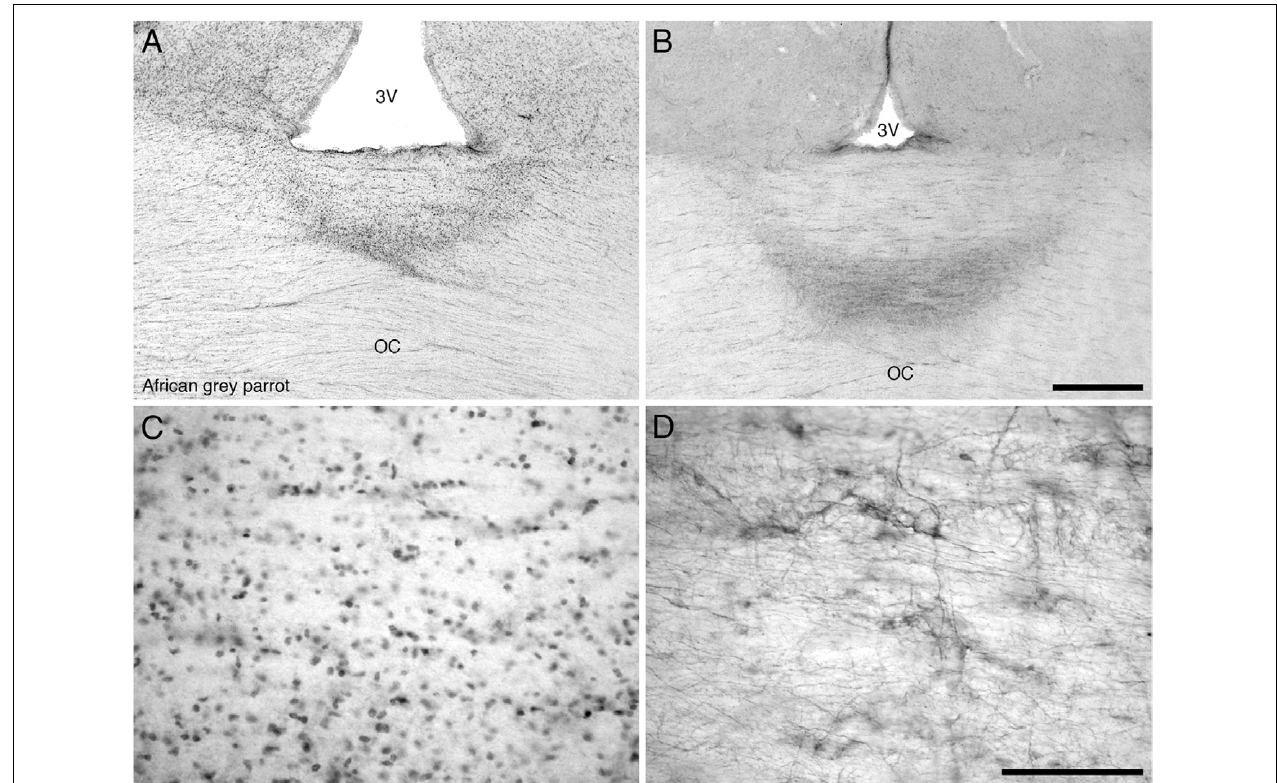
FIGURE 6 | Photomicrographs of PCNA – (A,C) and DCX (B,D) – immunostained coronal sections through the optic chiasm (OC) at its border with the floor of the third ventricle (3V) in the brain of the African grey parrot ( Psittacus erithacus ). (A) Accumulation of PCNA immunoreactive cells in the optic chiasm (OC). (C) A high magnification image of the PCNA immunoreactive cells in the optic chiasm. (B) A concentration of DCX immunoreactive cells and fibers in the optic chiasm. (D) A higher magnification image of DCX immunoreactive cells and fibers showing distinct cells and thick fibers. These images depict a potential neurogenic zone at the dorsal midline of the optic chiasm. In all images dorsal is to the top. Scale bar in (B) = 500 µ m and applies to (A,B) , scale bar in (D) = 100 µ m and applies to (C,D)